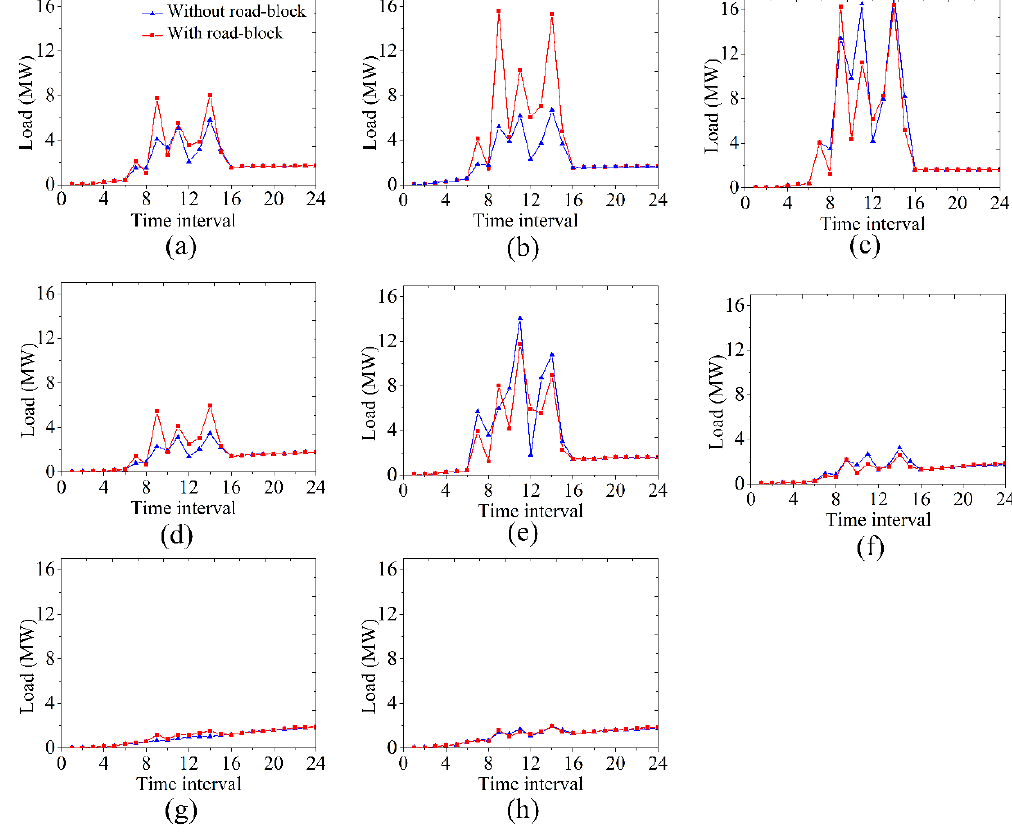
Figure 7. The load characteristics of FCS at ( a – d ) #5, #6, #20, #21 FCS, respectively; and at ( e – h ) #3, #10, #30, #31 FCS, respectively.